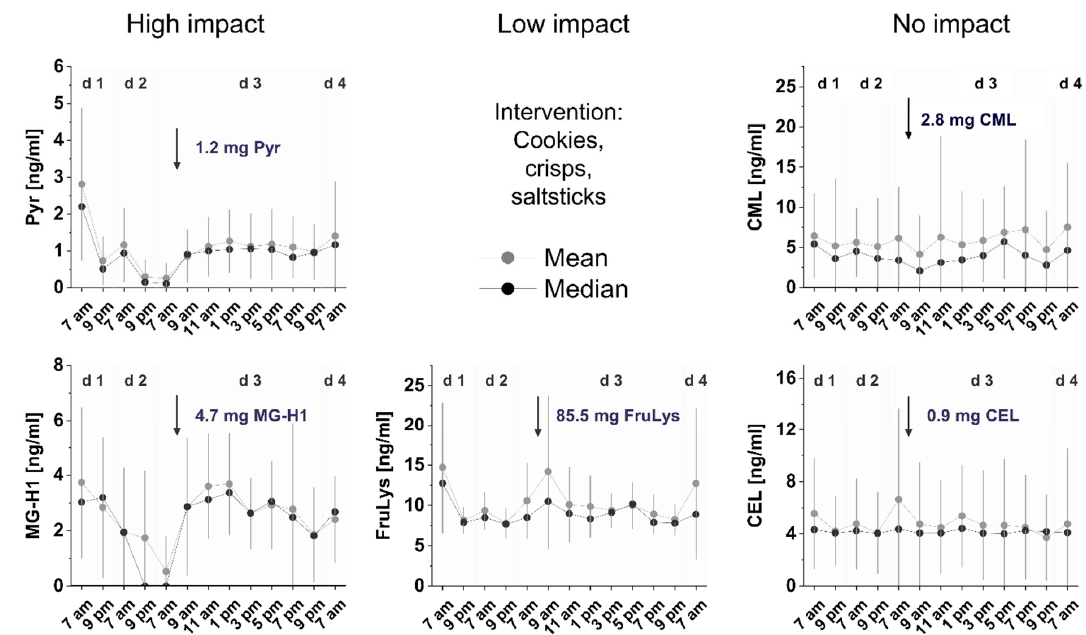
Figure 3. Impact of high MRP intervention meal on salivary MRP concentrations during a three-day low MRP diet. The arrows indicate the timepoint of intervention according to Table 3. Data indicate mean salivary MRP concentrations of n = 17 subjects with one-sided SD.